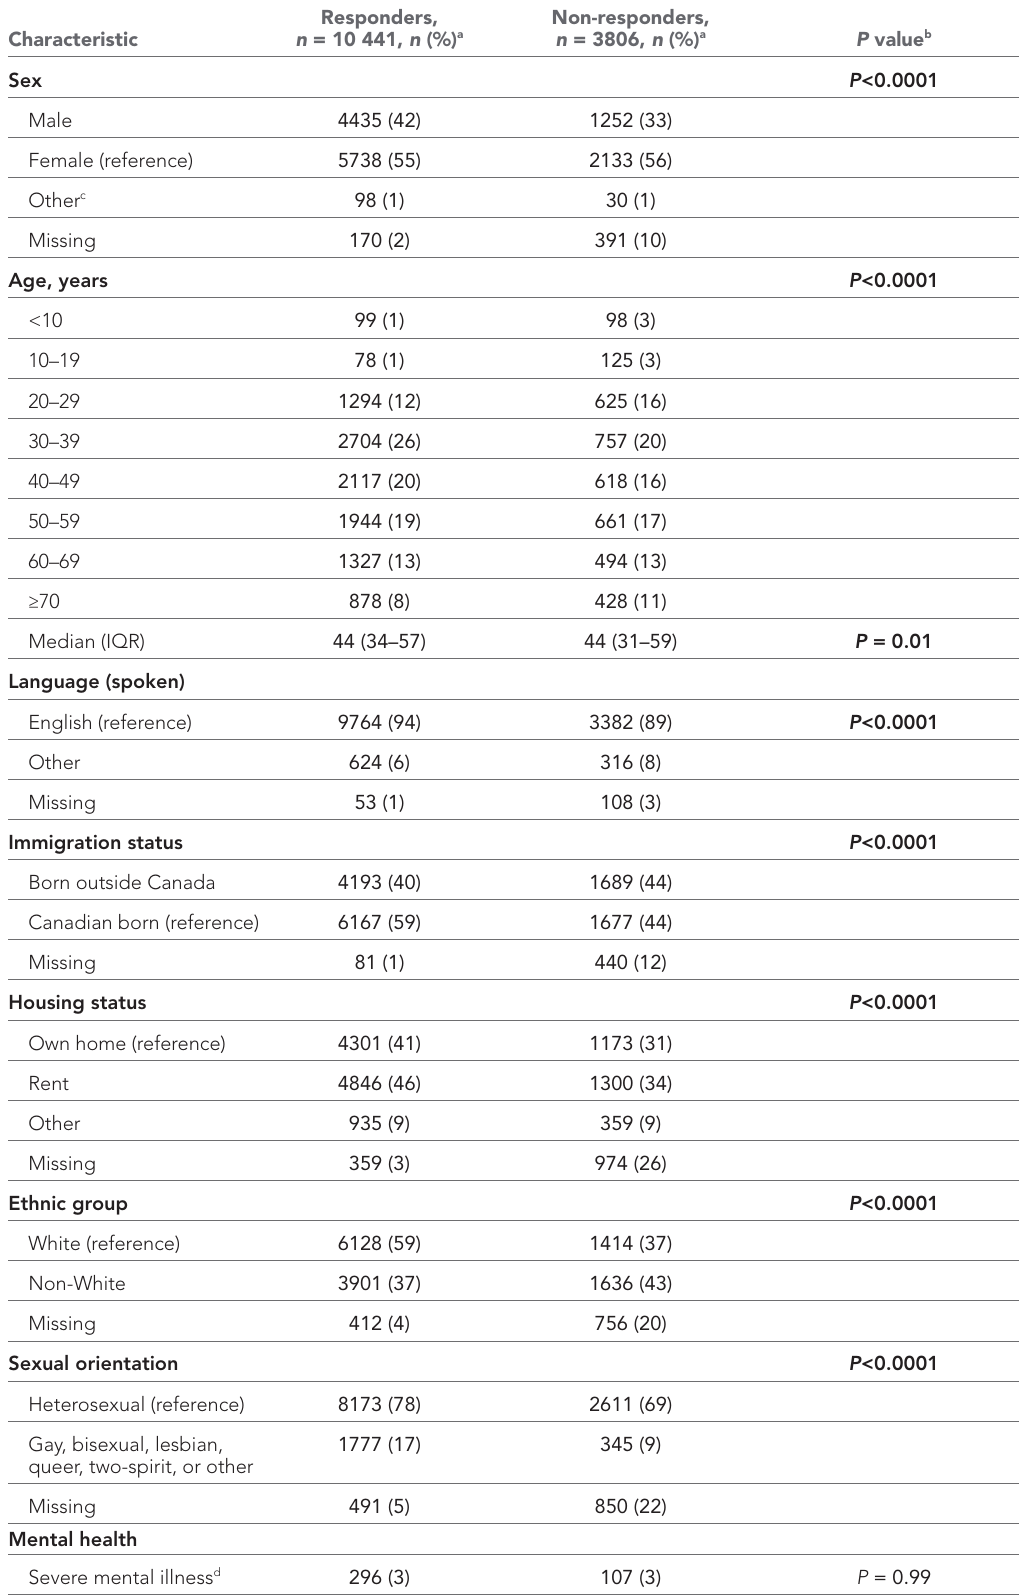
Responders, Non- responders, n = 10 441, n (%) a n = 3806, n (%)